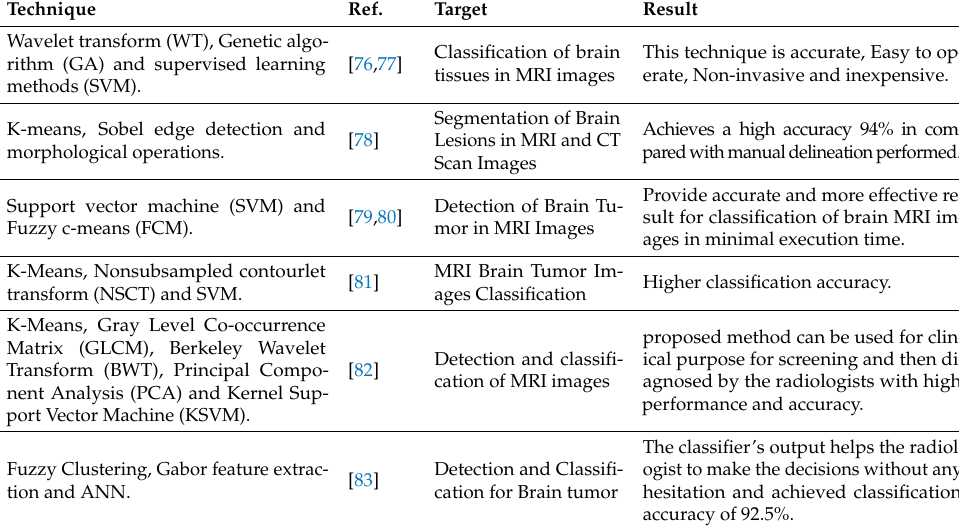
Table 3. Hybrid techniques in analyzing MR images. Technique Ref. Target